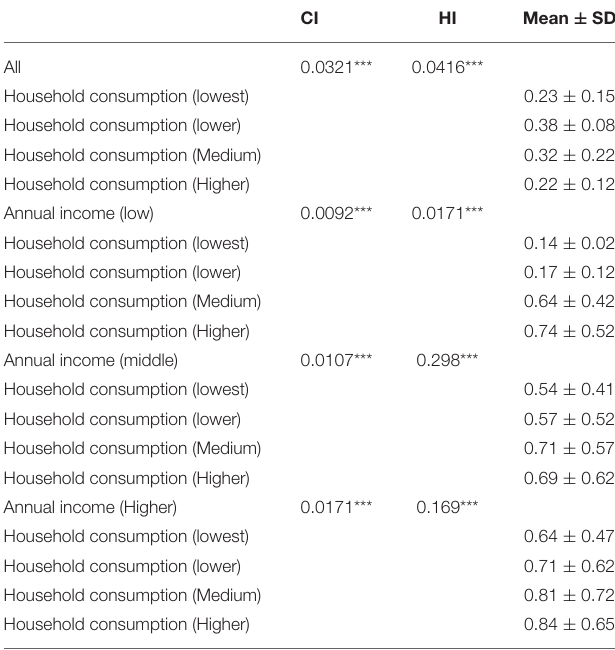
TABLE 3 | CI and HI of inequality in health education by income.